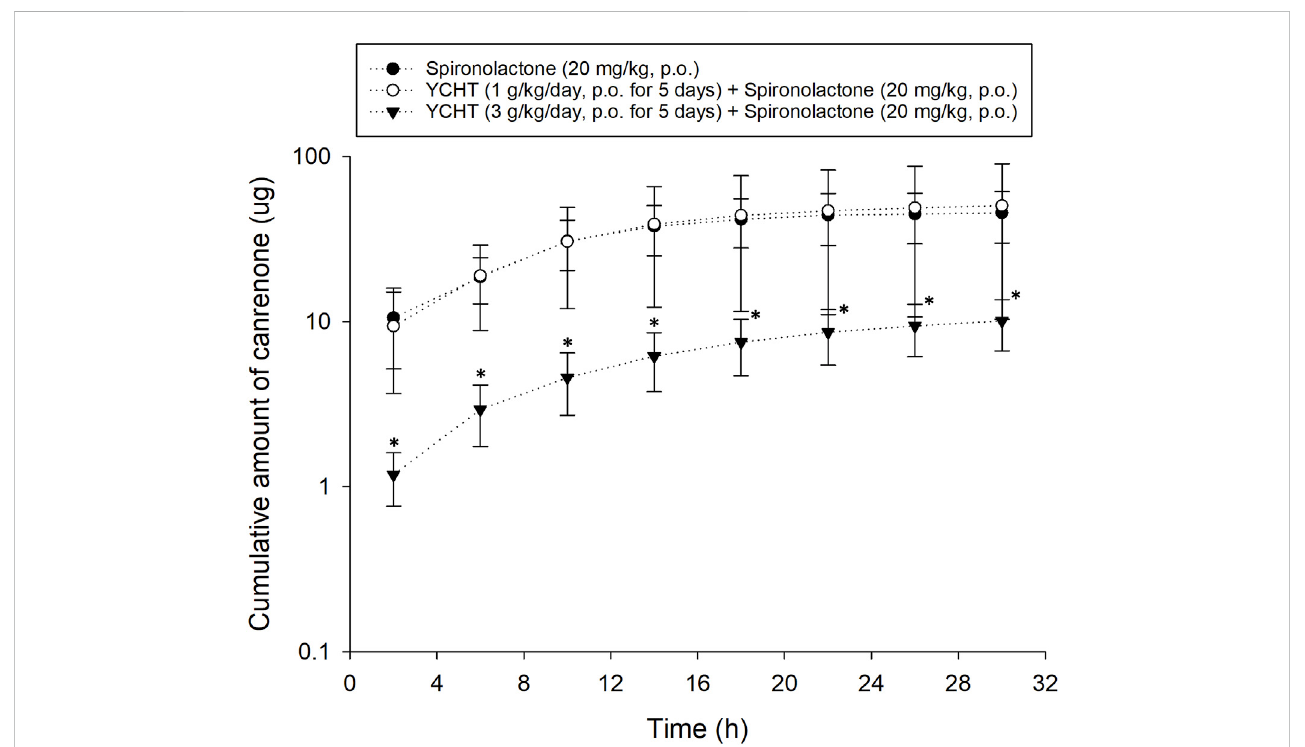
FIGURE 2 Cumulative amount of canrenone excreted in bile duct-ligated rat urine. The cumulative urinary amount of canrenone versus the time midpoint illustrated the amount of canrenone excreted after using spironolactone, pretreatment with 1 g/kg Yin-Chen-Hao-Tang, and pretreatment with 3 g/kg Yin- Chen-Hao-Tang groups. * p -value < .05 compared to the vehicle